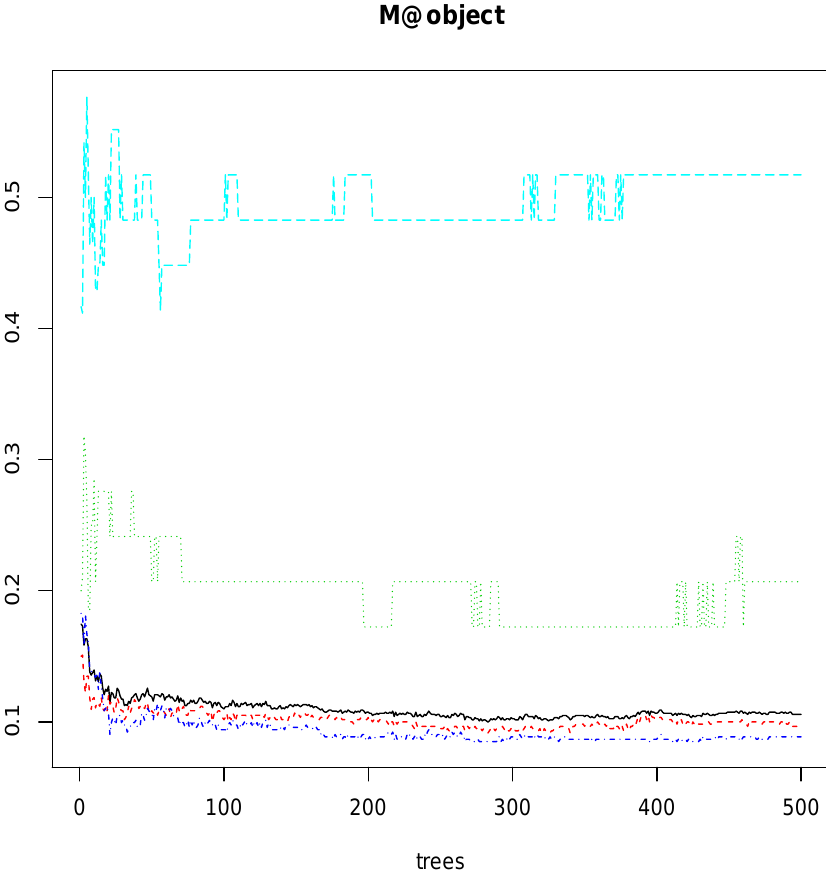
Figure 2. Random forest (RF) stabilization with 500